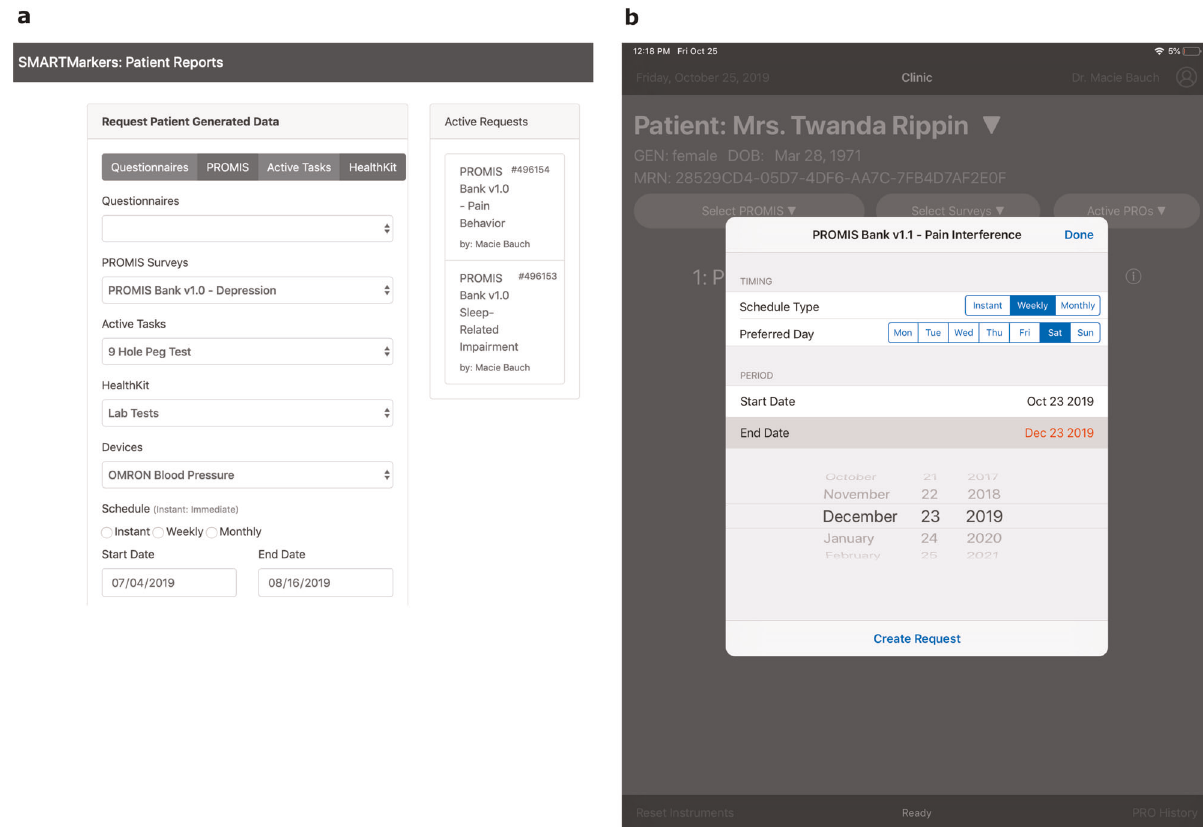
Fig. 4 Practitioner apps at point of care. a EHR app running within the context of an EHR session for dispatching PGHD Instrument requests. b Practitioner Tablet app to dispatch or administer instrument sessions for ambulatory settings.